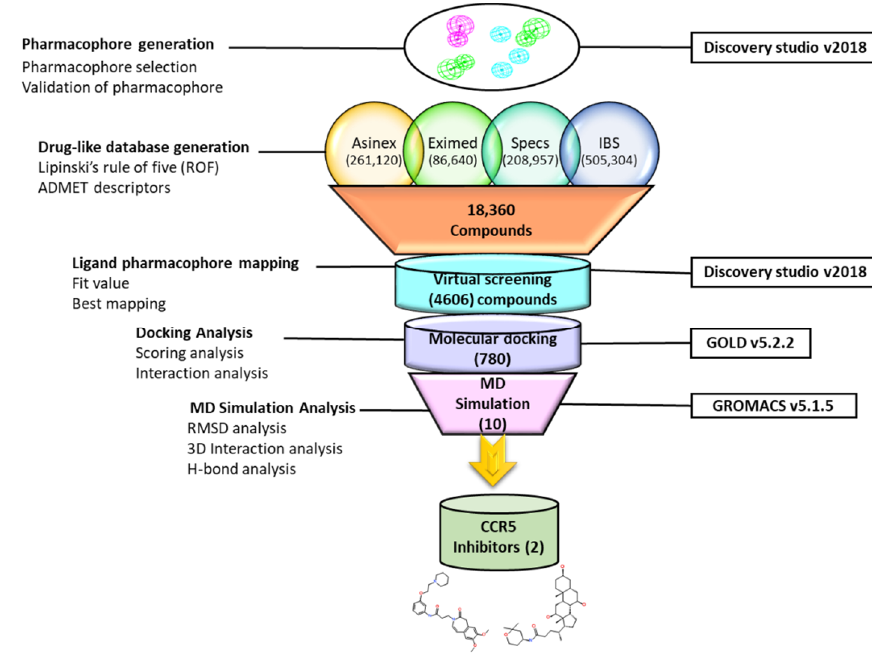
Figure 1. Illustrative workflow used for the identification of potential CCR5 inhibitors.